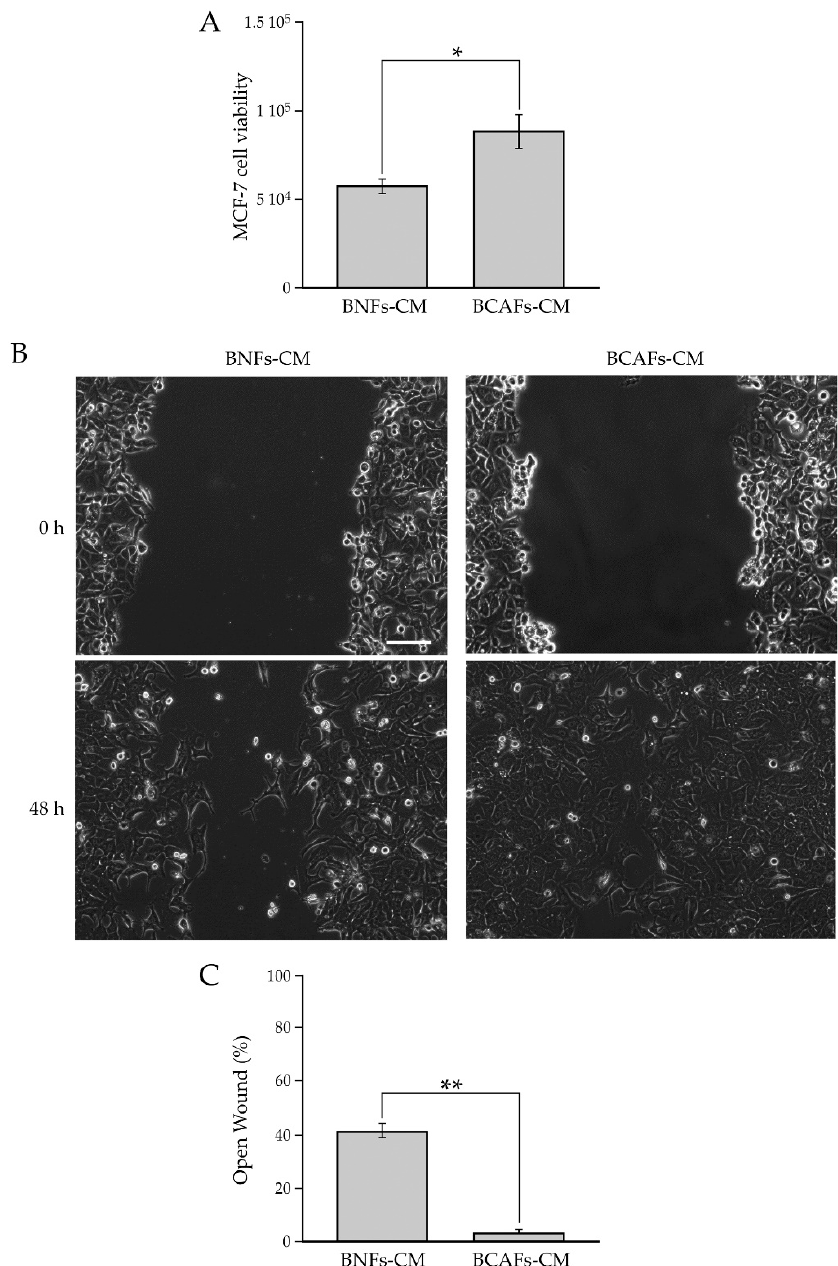
Figure 2. ( A ) Influence of conditioned media from BNFs (BNFs-CM) and BCAFs (BCAFs-CM) on MCF-7 cell viability. Data are means of at least three independent experiments ± S.E. * p < 0.05. ( B , C ) Influence of conditioned media from BNFs (BNFs-CM) and BCAFs (BCAFs-CM) on MCF-7 cell migration. ( B ) Wound-Healing Assay performed on MCF-7 cells treated with fibroblast-conditioned media. Representative images of three independent experiments show the same fields with scratching at 0 and 48 h after wounding. Scale bar 100 µ m. Magnification × 10. ( C) Migratory capability quantification of MCF-7 cells. Wound widths were measured at 0 and 48 h after wounding. Data are expressed as percentage of fold decrease in open wound area compared with control (0 h) set as 100% and are reported as mean of three independent experiments ± S.E. ** p <